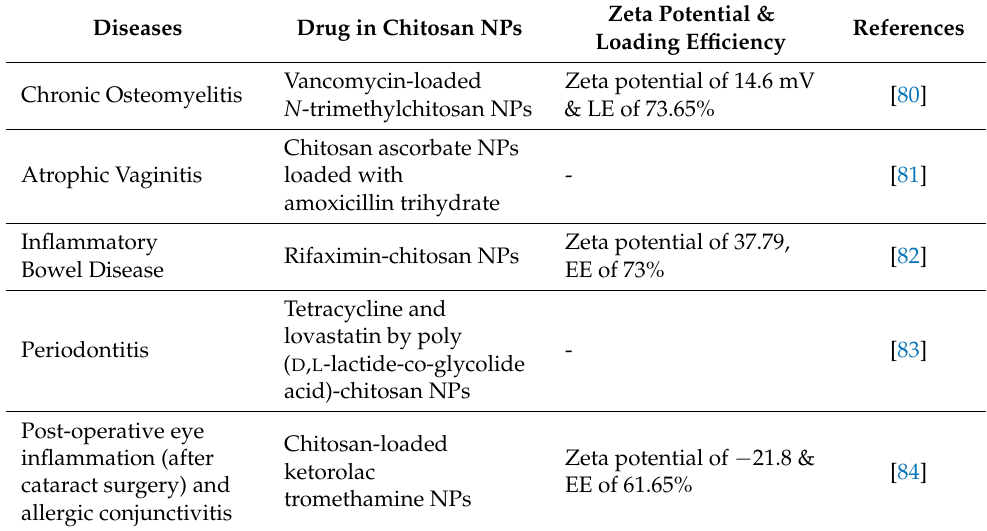
Table 4. Chitosan NPs in infectious and inflammatory